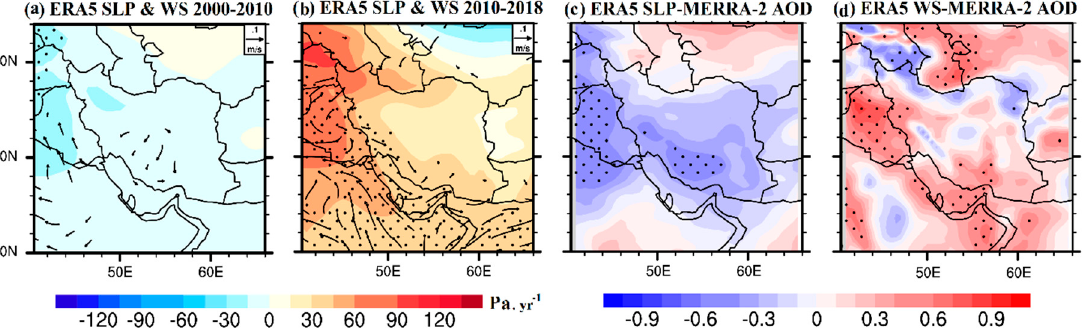
Figure 8. Spatial distributions of the winter (DJF) linear trends in the ERA5-derived sea level pressure and wind speed during the periods 2000–2010 ( a ) and 2010–2018 ( b ) and their correlations with the MERRA-2 AOD ( c , d ) from 2000 to 2018 over Iran. The black dots denote statistical significance of the trends and correlations at a 95% confidence level ( p < 0.05). Only statistically significant wind trends ( p < 0.05) are plotted in vectors.